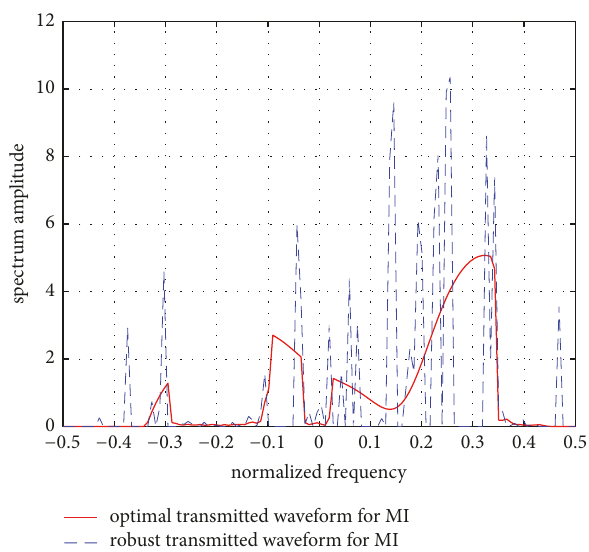
Figure 12: Waveform results for multiple